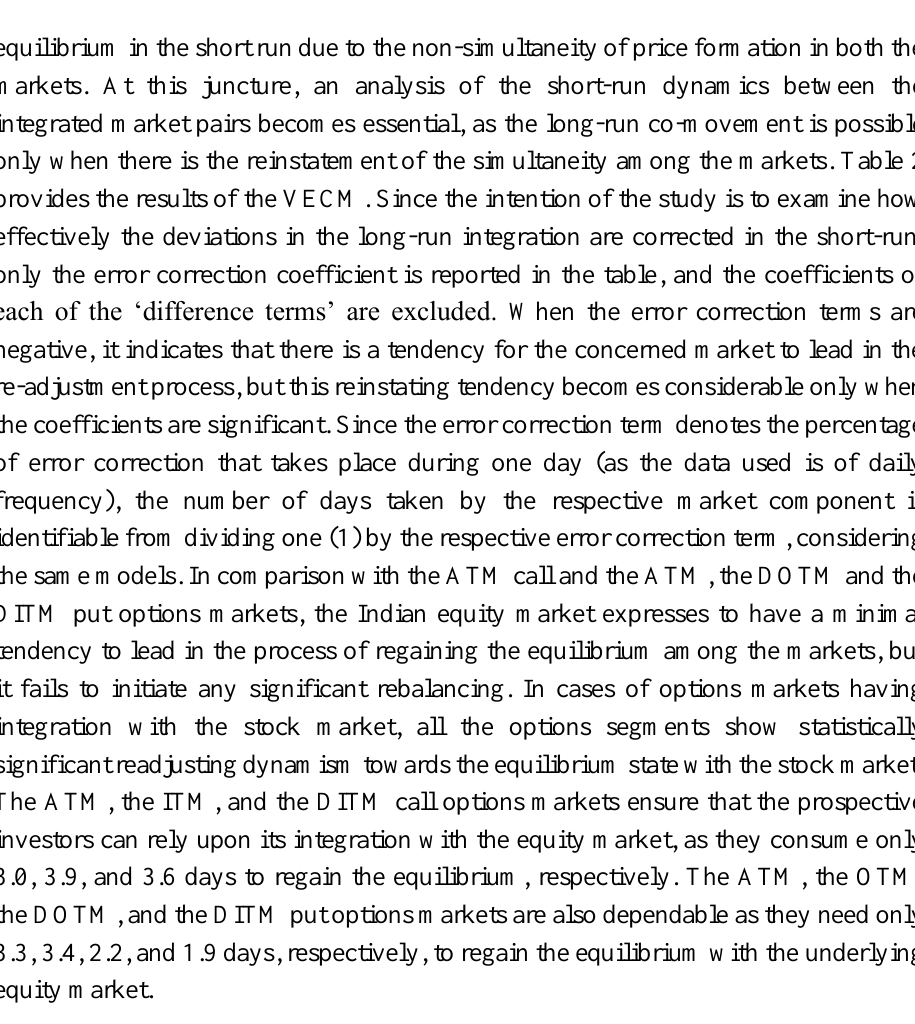
Table 2: Short-Run Dynamics Between the Stock and the Options Market